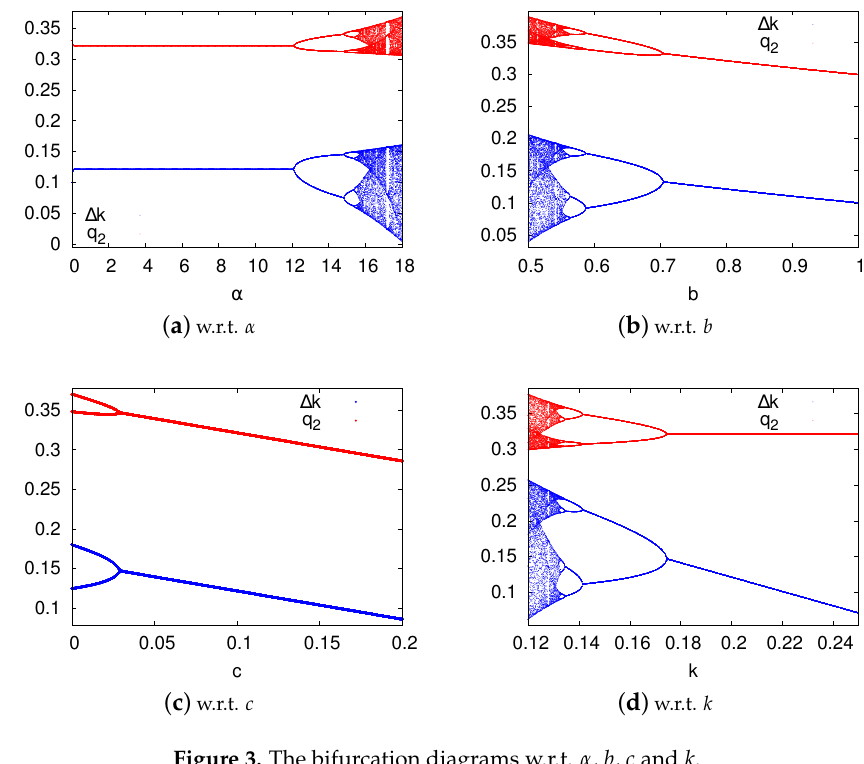
Figure 3. The bifurcation diagrams w.r.t. α , b , c and k .